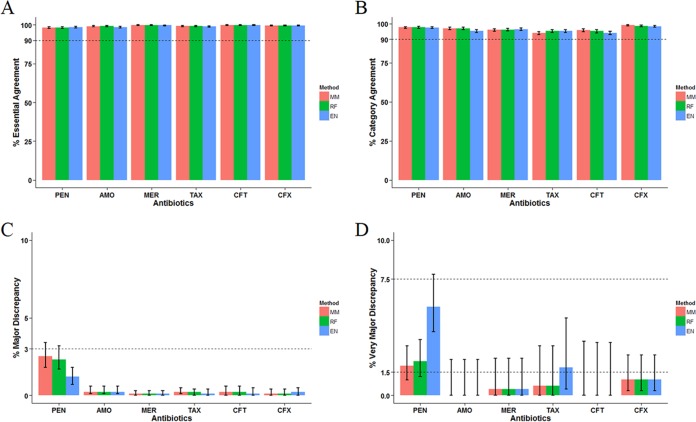
Agreement between the predicted MIC and the microdilution MIC among isolates of trained PBP types. The mode MIC (MM) model assigned the most frequently seen MIC of a trained PBP type to a test isolate of the same PBP type. The random forest (RF) and elastic net (EN) models were designed to quantify the contribution of each individual TPD position from the training data set and combine these contributions to make a prediction. See Materials and Methods for detailed model description. The percent essential agreement (A), category agreement (B), major discrepancy (C), and very major discrepancy (D) were calculated for six antibiotics. Error bars are 95% CIs.